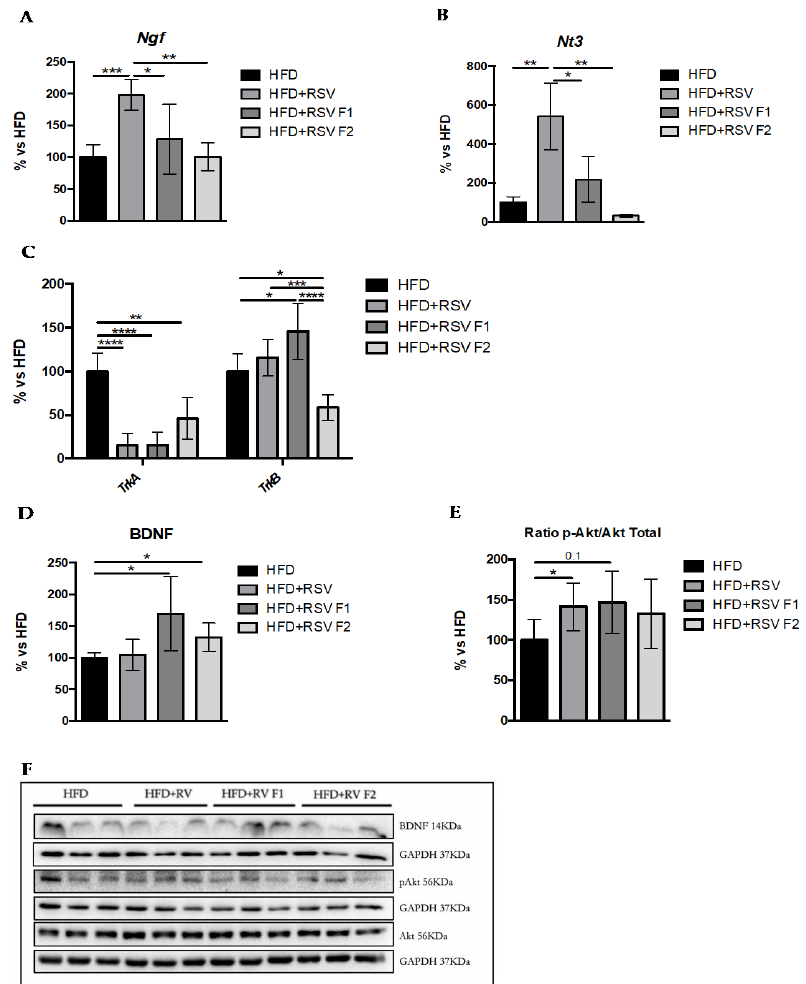
Figure 5. Synaptic plasticity markers in the hippocampus of SAMP8 mice at 6 months of age. Results of gene expression of Ngf ( A ), Nt3 ( B ), and their receptors TrkA and TrkB ( C ). Quantifications ( D , E ) and representative results by WB of BDNF and p-Akt ( F ). Gene expression levels were measured by real-time PCR from hippocampal tissue. Data from each group were compared to the HFD group (set at 100%). Mean Standard error of the mean (SEM) in bar graphs are adjusted to 100% for each gene of HFD group; n = 16–24 (HFD n = 4–6, HFD + RSV n = 4–6, HFD + RSV F1 n = 4–6, HFD + RSV F2 n = 4–6; for each group, females n = 3–4, males n = 3–4). Statistics: *p < 0.05; **p <0.01; ***p < 0.001; ****p < 0.0001.